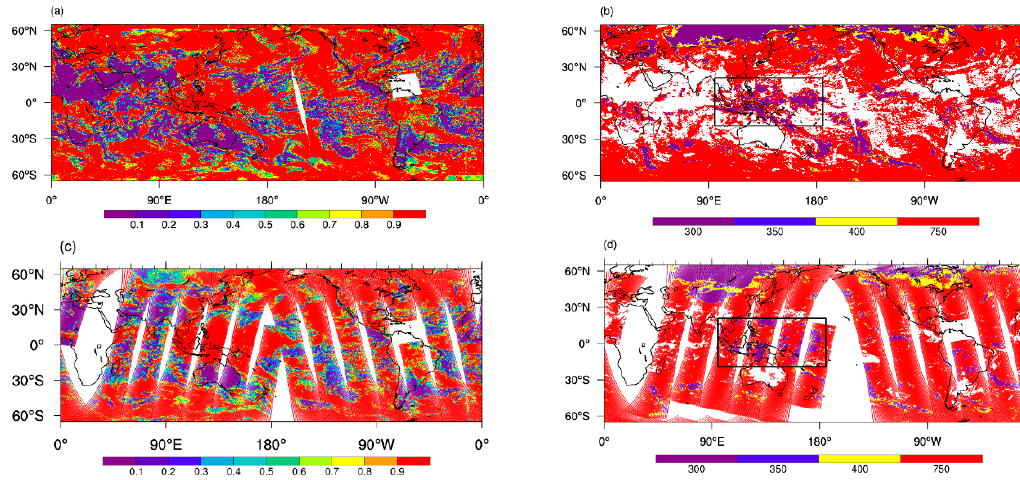
Figure 6. Cloud parameter product from MERSI-2 (a–b) and the remapped cloud parameters on MWTS-2 fields of view (FOVs) (c–d). (a) and (c) show the cloud fraction, and (b) and (d) show the cloud top height. As discussed in Section 3.2, only four unified cloud top heights (300, 350, 400 and 750 hPa) can be used to evaluate the impacts of clouds.